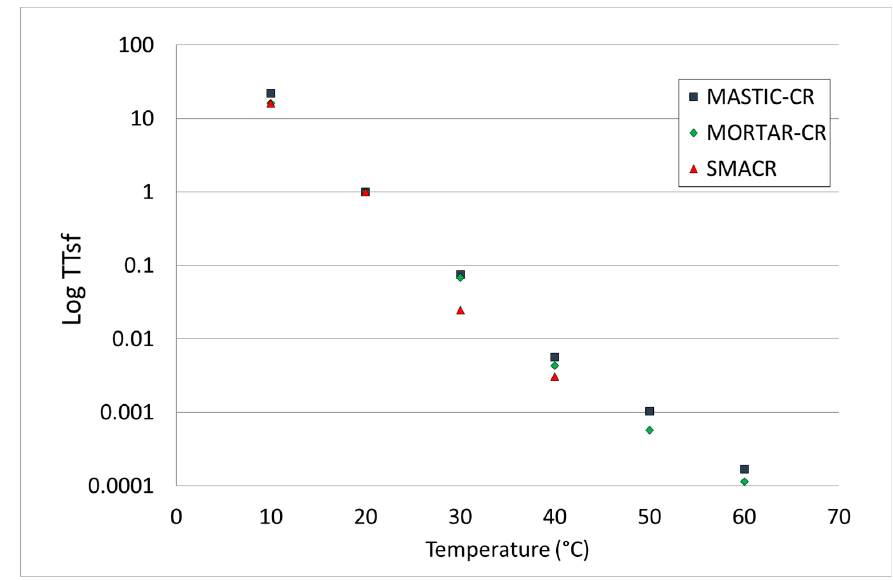
Figure 11. LogTTsf - Temperature function. Figure 11. LogTTsf-Temperature